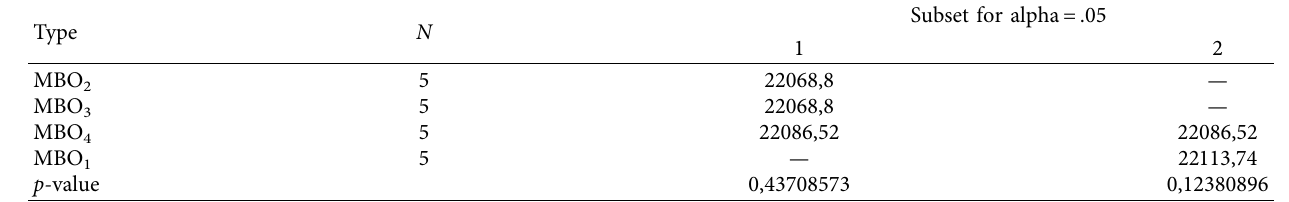
Table 5: Tukey’s test for the kroE100 instance.